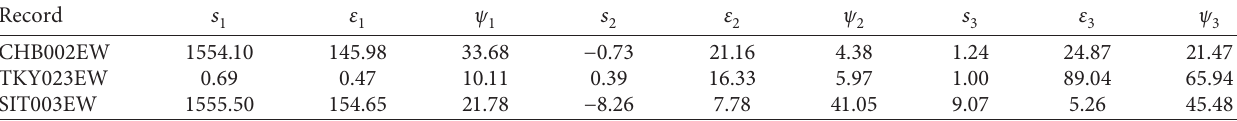
Table 5: Parameters controlling variance σ for each